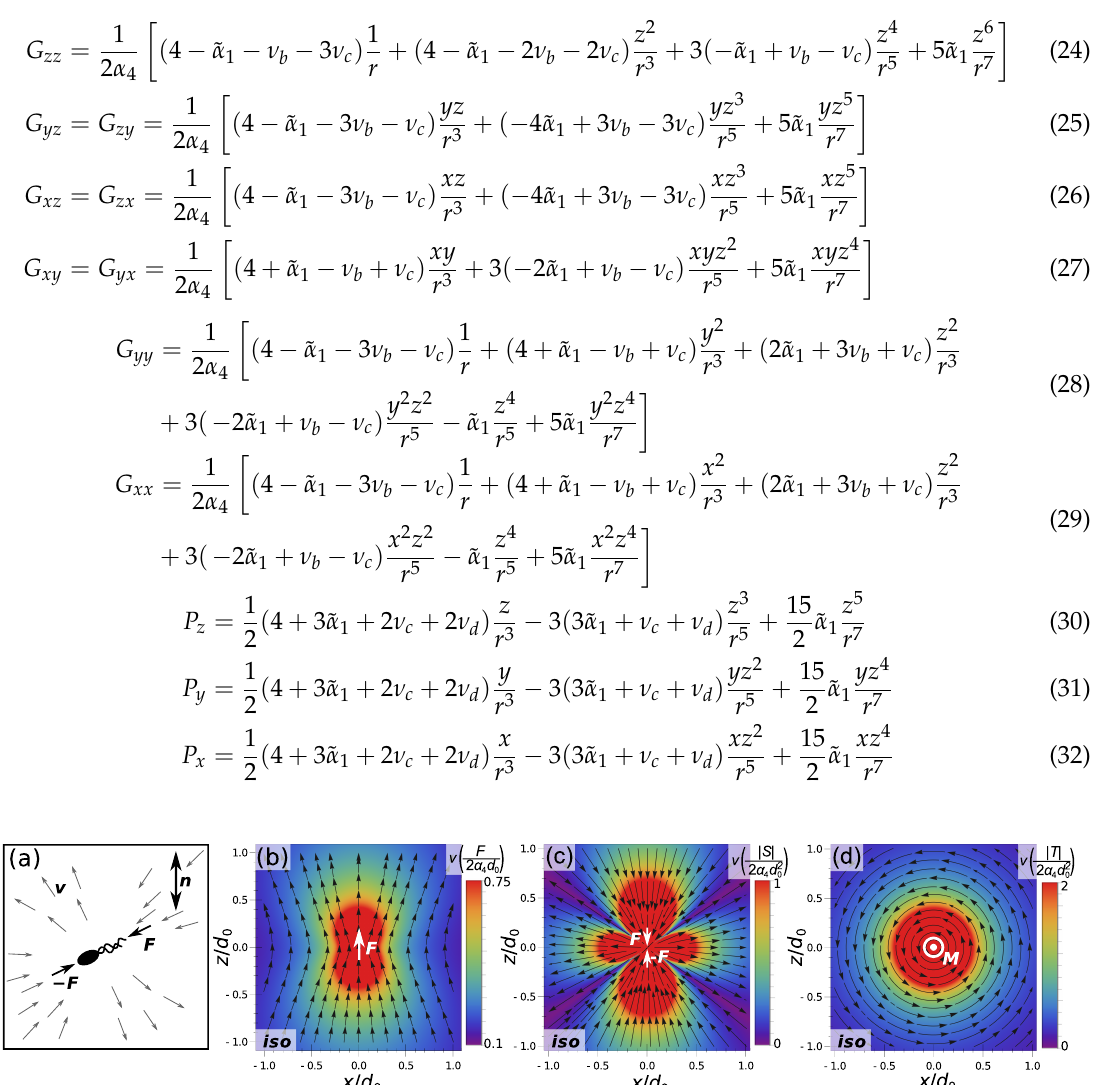
Figure 1. ( a ) an outline of the problem—a microswimmer exerts forces upon the surrounding nematic fluid with homogeneous director (cid:126) n , driving a flow field (cid:126) v ( (cid:126) r ) . A set of elementary flow profile solutions for isotropic fluids is shown as reference for later comparison: ( b ) Stokeslet flow due to a point force; ( c ) stresslet flow due to a pair of opposite forces (a force dipole), and ( d ) rotlet flow due to a point torque. The magnitude of the flow field as noted in the colorbar is given in basic quantities (see text for